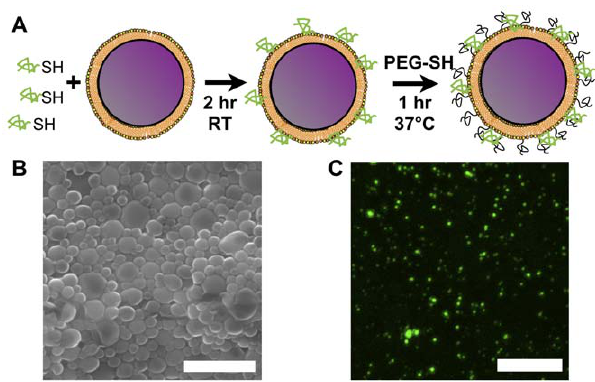
Figure 1. Synthesis of PLGA NPs with surface-conjugated VMP001 (VMP001-NPs). (A) Schematic illustration of synthesis of lipid-enveloped PLGA NPs with surface-conjugated VMP001. PLGA NPs were incubated with thiolated VMP001, conjugating the antigen to maleimide-functionalized lipids displayed on the particle membranes. Particles were then PEGylated in a reaction with PEG-thiol. (B) A scanning electron microcopy image of VMP001-NPs. Scale bar, 2 m m. (C) Confocal microscopy image of VMP001-NPs incubated with anti-his-tag and fluorescent secondary antibodies to detect particle surface- conjugated VMP001. Scale bar, 10 m m.